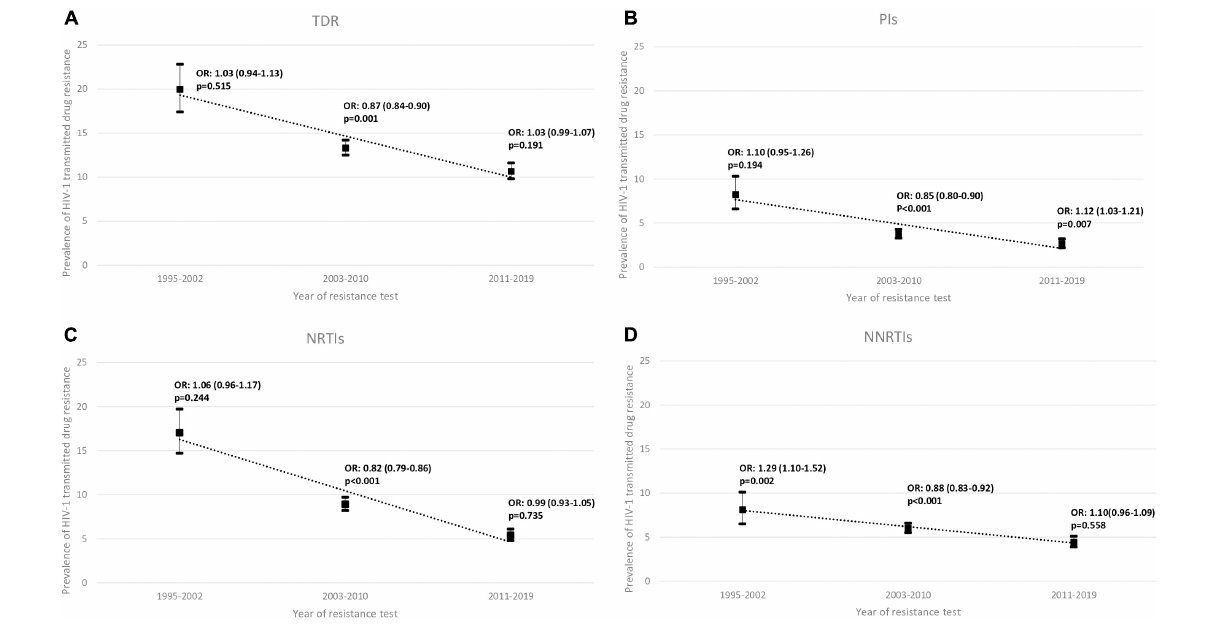
FIGURE 1 | Proportion of (A) overall transmitted drug resistance (TDR), (B) of protease inhibitors (PIs), (C) of nucleoside reverse transcriptase inhibitor (NRTIs) and (D) of non-nucleoside reverse transcriptase inhibitor (NNRTIs) in sequences from drug-naïve patients between three periods 1995–2002, 2003–2010,